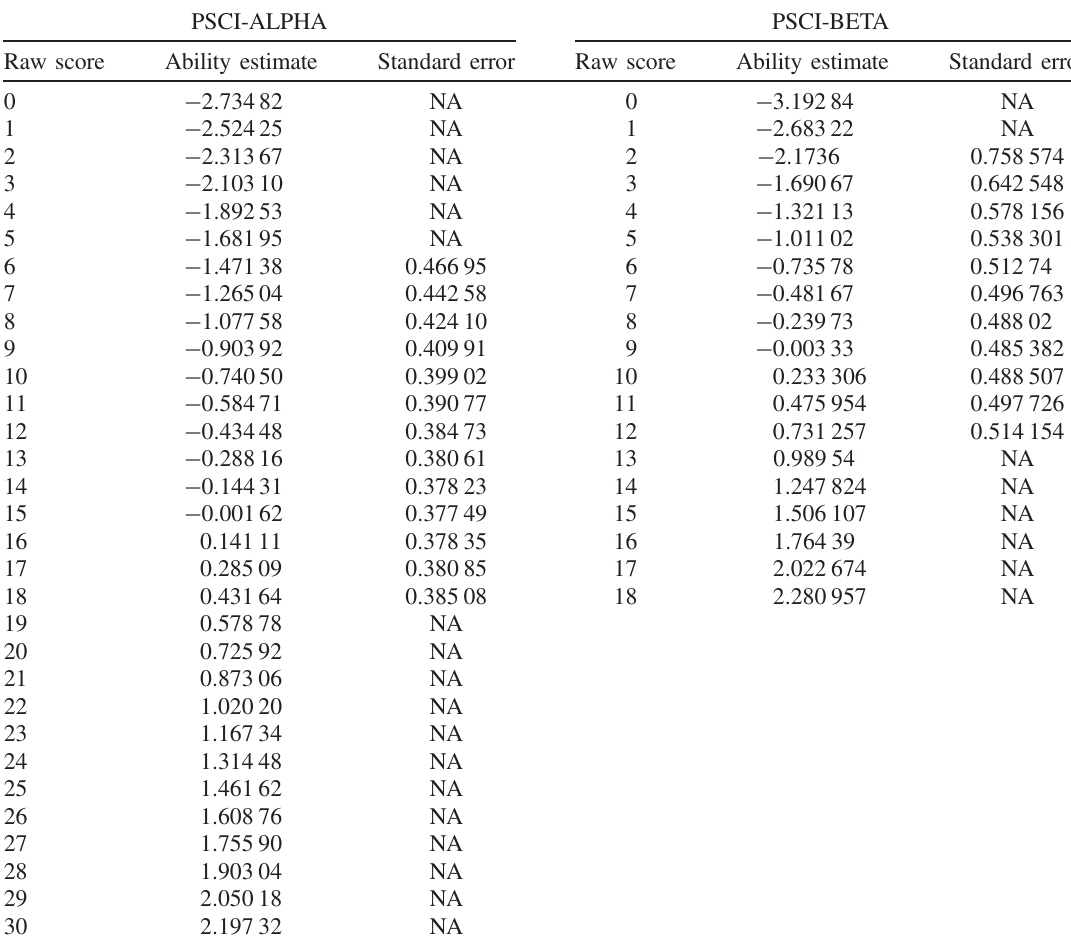
TABLE VI. Person parameters for the sample in field testing; CML Rasch estimation. Values valid only for the persons submitting answers to all questions (NA Group1).